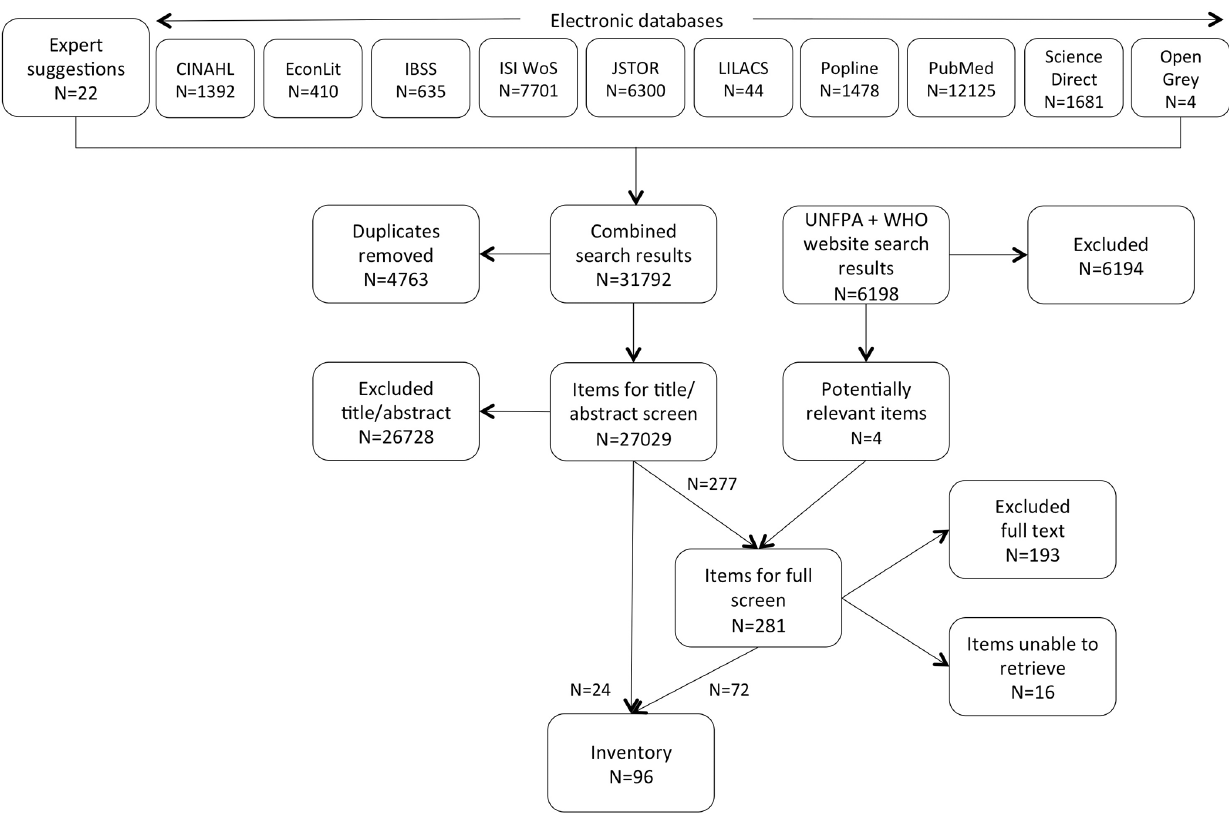
Figure 1. Mapping results.